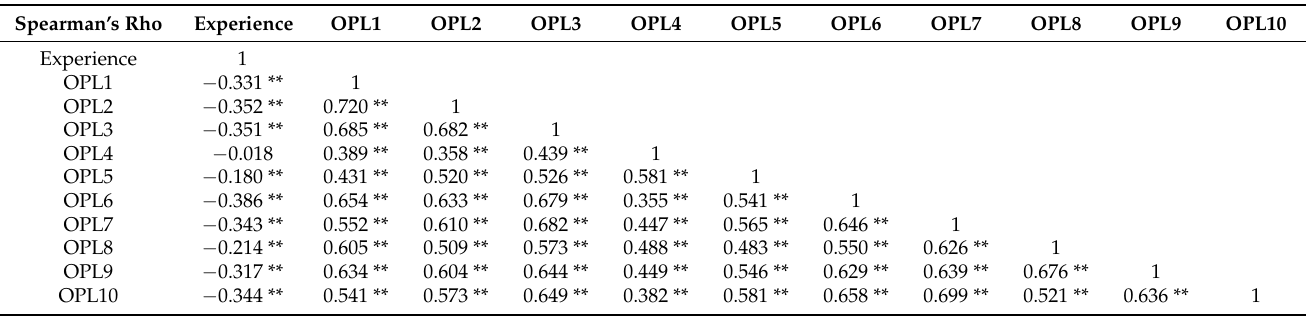
Table 4. Correlation coefficient between the H&S considerations at the planning